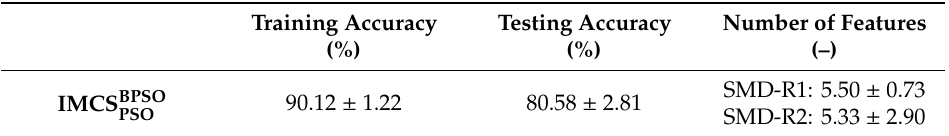
Table 3. Classification performance of IMCS BPSO space based on both healthy and defective